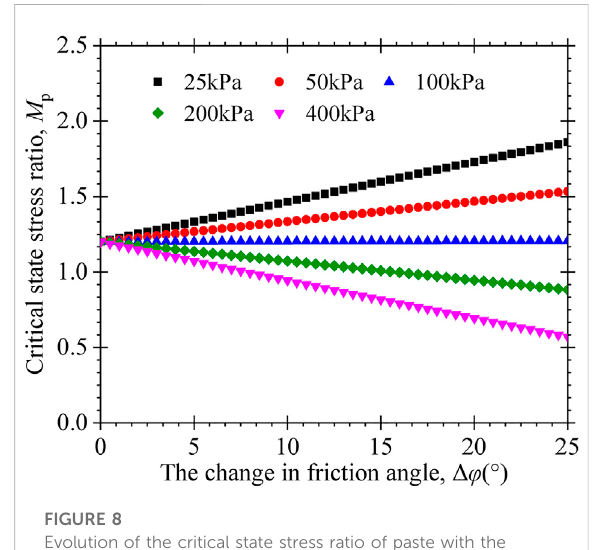
Evolution of the critical state stress ratio of paste with the internal friction angle change parameter of the paste under different con fi ning